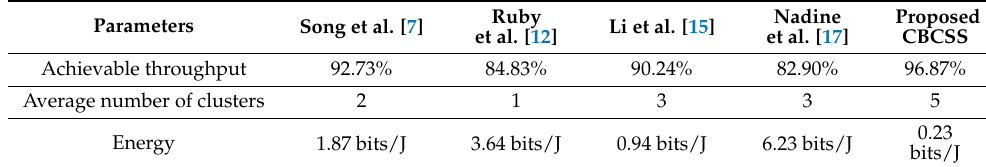
Table 2. The comparison of the existing methods and proposed